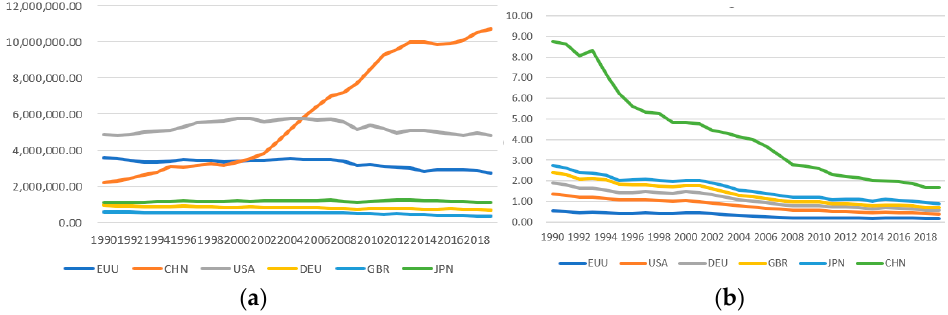
Figure 1. ( a ) Change trend of total carbon emissions; ( b ) change trend of carbon emission intensity. Data source: World Bank.